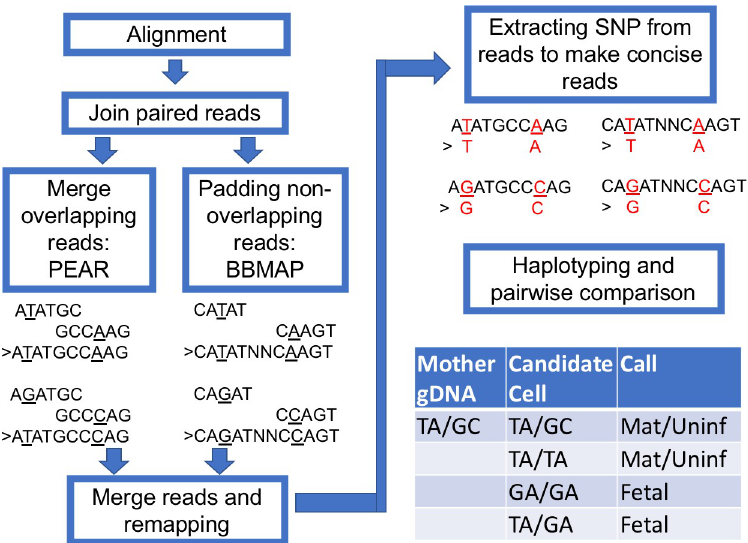
Fig 5. The workflow for haplotyping. The paired aligned reads were jointed with PEAR and padded with BBMap short read aligner when a gap exists. The new joint reads were remapped with BWA-MEM with a modified configuration. The highly polymorphic sites were extracted for constructing concise haplotypes. To demonstrate the workflow, we present example short reads with TA and GC haplotypes. groups to represent the haplotype of this amplicon. To compare the haplotypes of more than two samples, all the top reads of each sample were pooled together, and their distances were calculated, which will determine if these samples share the same read group (haplotype). For example, the maternal gDNA carried a mocked haplotype 1 (TA) and haplotype 2 (GC). A pos-